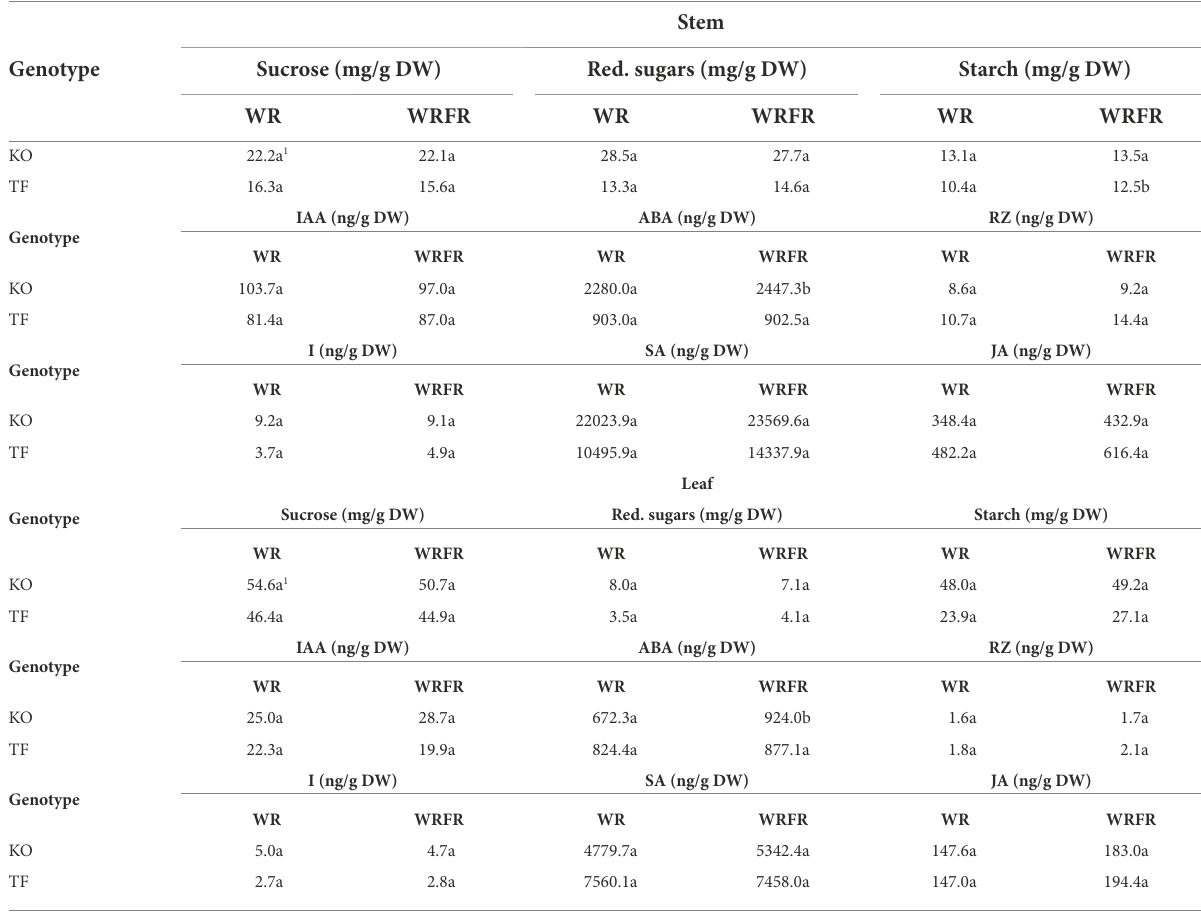
TABLE 6 Least-square means (LS means) of the sugar and hormone concentrations in the stem and leaves of the order 1 long axis measured on the 19th day of cultivation for Knock Out ® Radrazz (KO) and ‘The Fairy’ (TF) grown in a climate chamber under two light conditions: WR and WRFR.